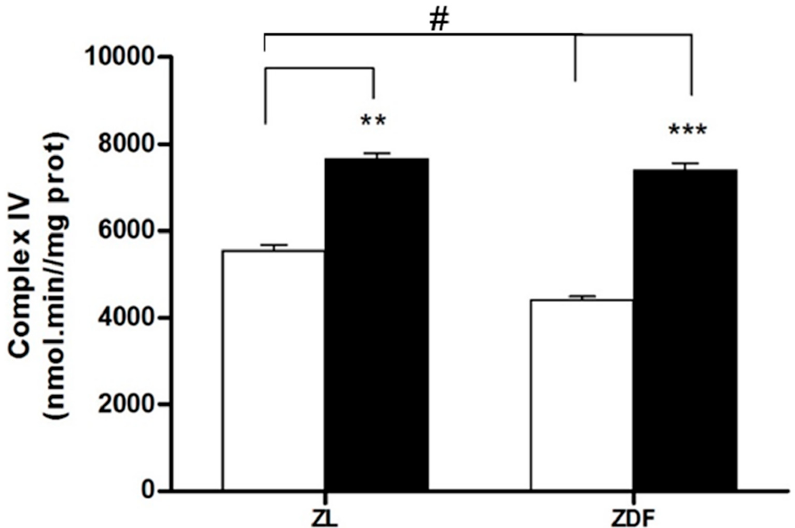
Figure 4. Activity of complex IV of the electron transport chain (ETC) in renal mitochondria isolated from different treatment groups. Values are the means ± S.E.M. ZL, Zücker lean rats; ZDF, Zücker diabetic fatty rats. Superscript letters refer to significant difference measured using two-way ANOVA (** p < 0.01, *** p < 0.001 M-ZDF compared with C-ZDF, and M-ZL compared with C-ZL rats; ## p < 0.01 C-ZDF compared with C-ZL rats).